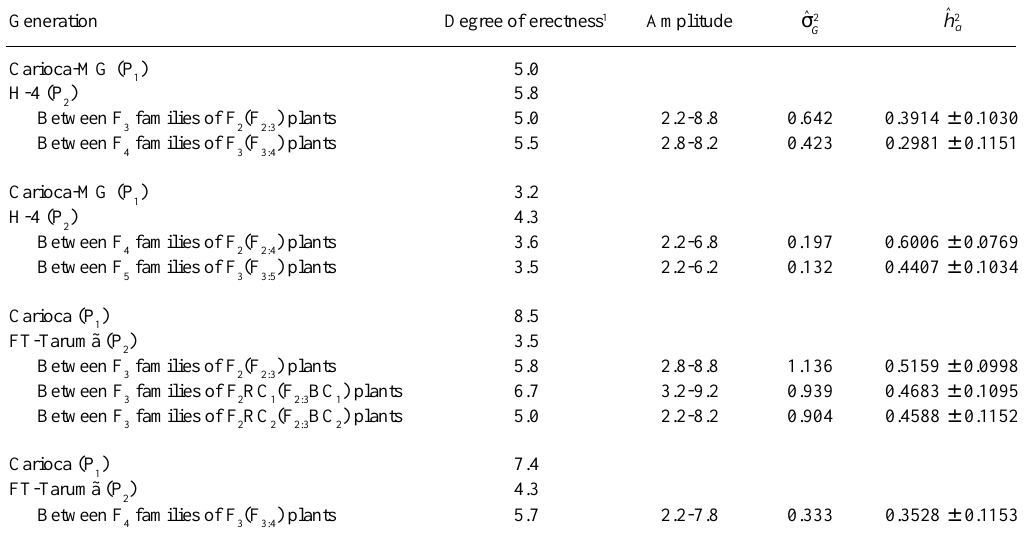
Table IV - Average values of degree of erectness, their amplitudes, genetic variances and heritabilities, estimated for the bean families evaluated in the